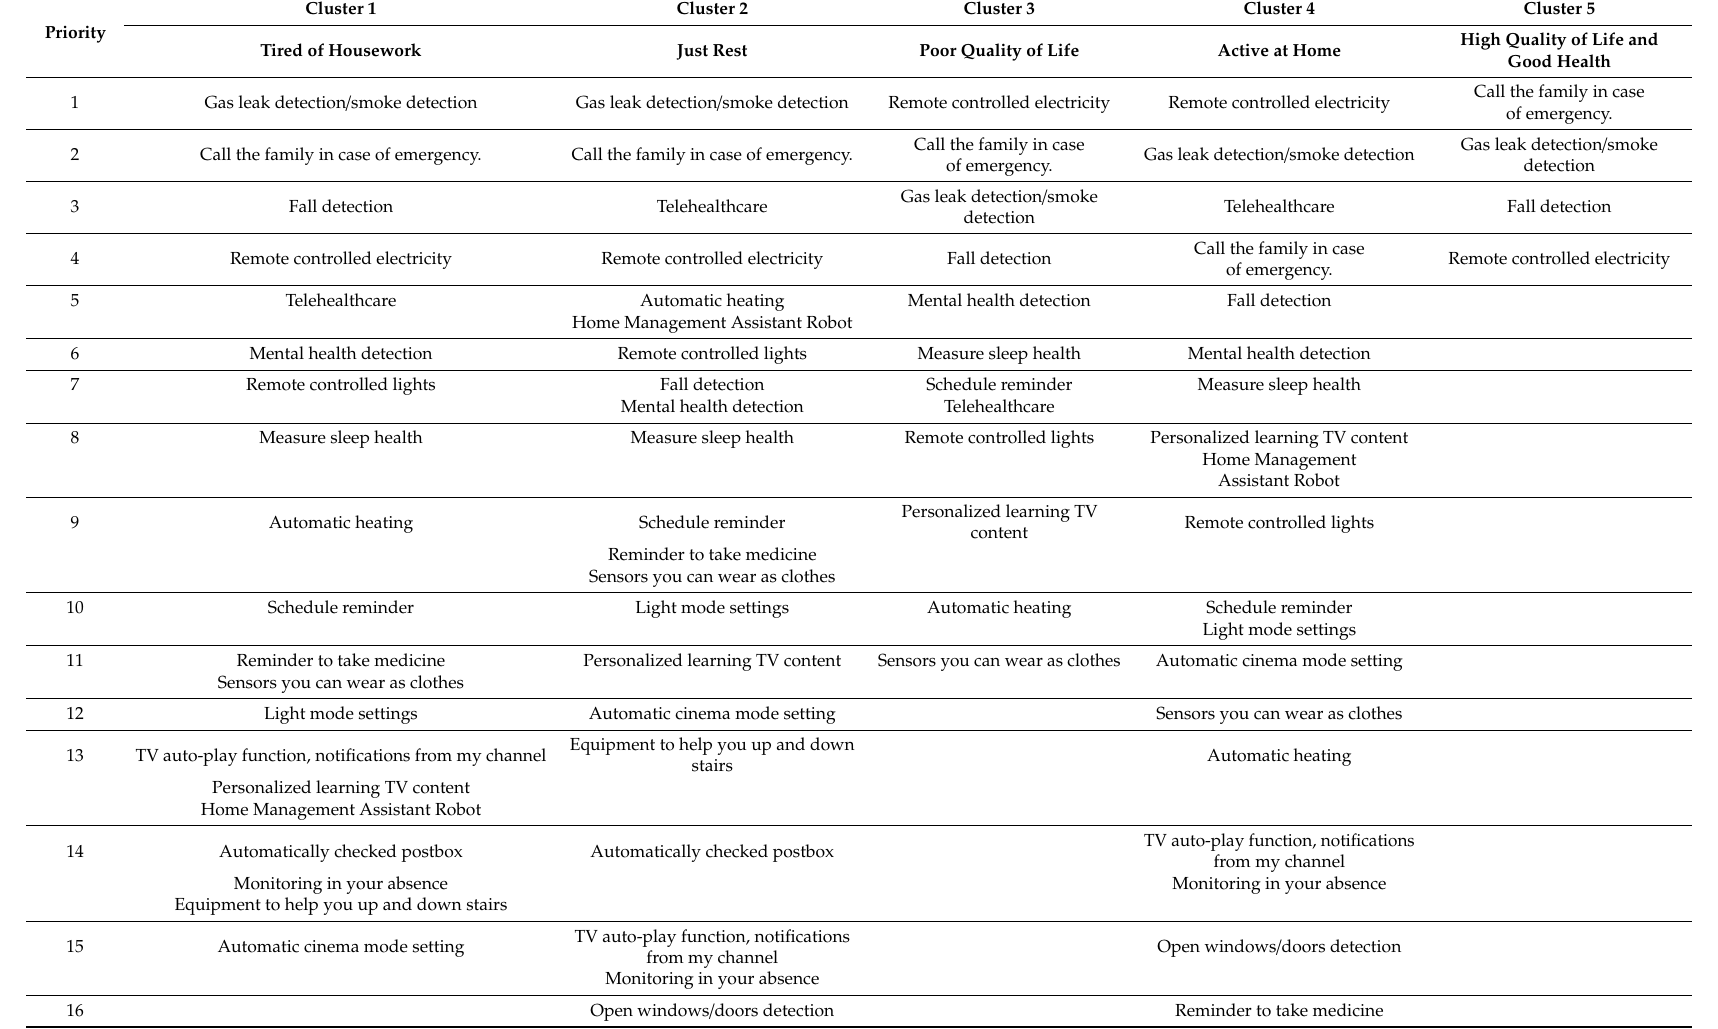
Table 6. The priority of smart home functions for each